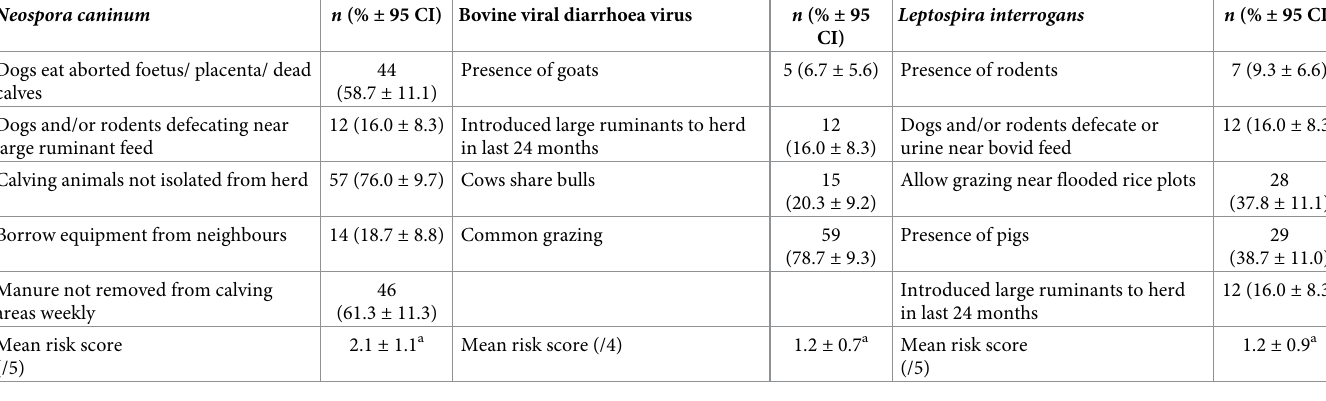
Leptospira interrogans n (% ± 95 CI) CI)